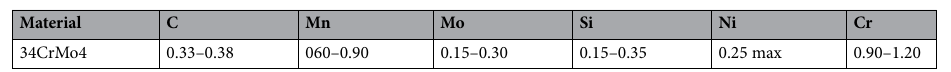
Table 1. Chemical composition [wt%] of